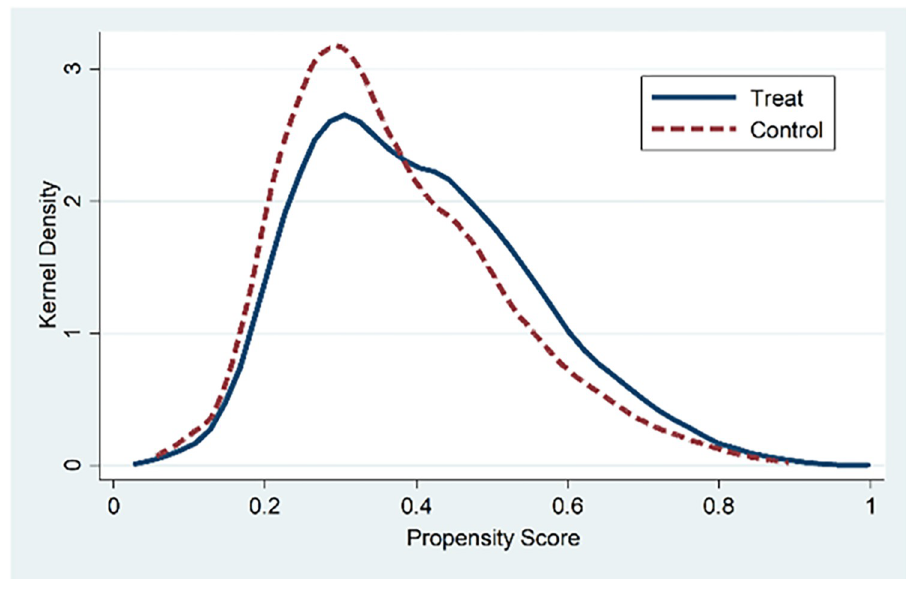
Fig 2. After matching.